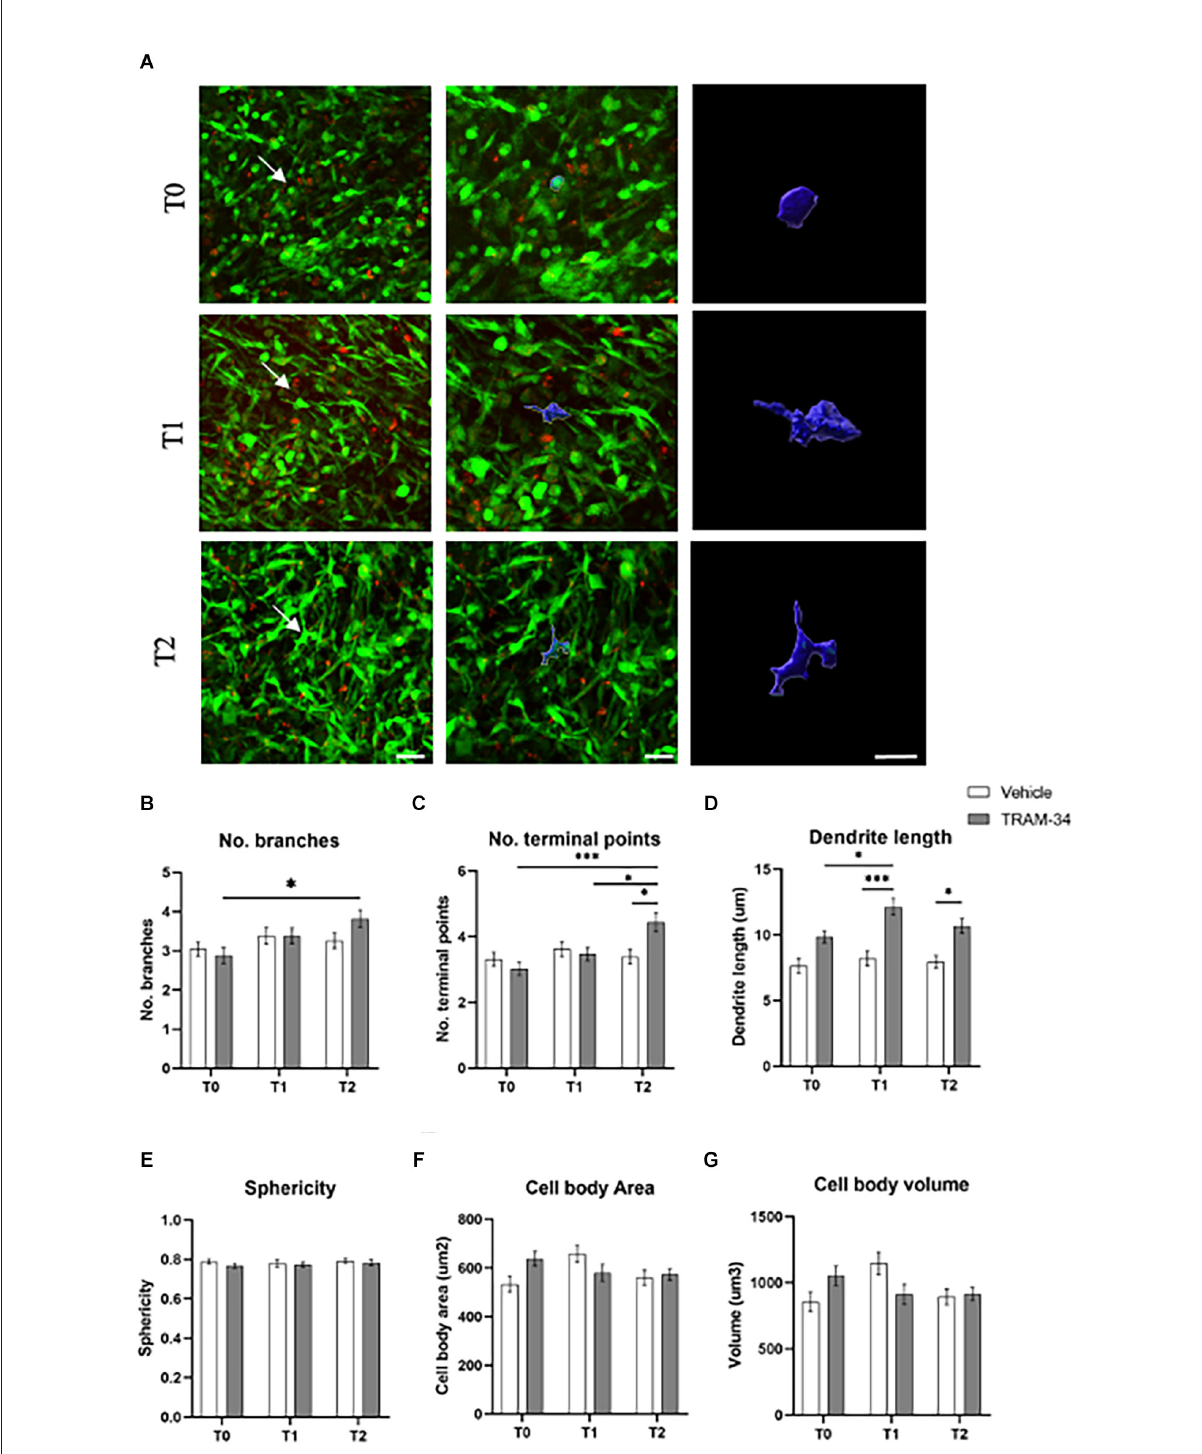
FIGURE3 Morphology analysis of TAMs. (A) Representative 3D IMARIS reconstruction of TAMs. The reconstruction above was performed at T0, T1, and T2 of TRAM-34 treatment. The images on the center (scale bar = 20 µ m) and in the right (scale bar = 10 µ m) show the reconstruction of TAMs indicated with a white arrow in the picture on the left (scale bar = 30 µ m). (B) The number of branches/cell. (C) The number of terminal points/cells. (D) The total branch length for each cell is considered as “dendrite” for the IMARIS Filaments function ( µ m). (E) Sphericity (1.0 perfect sphere; 0 non sphere). (F) Cell area ( µ m 2 ). (G) Cell volume ( µ m 3 ). White bars are for vehicle-treated animals, while the gray ones are for TRAM-34-treated animals. 50 cells from five mice. Two-way ANOVA followed by Tukey’s Post hoc correction ± S.E. ∗ p < 0.05; ∗∗∗ p < 0.001. Scale bar 10 µ